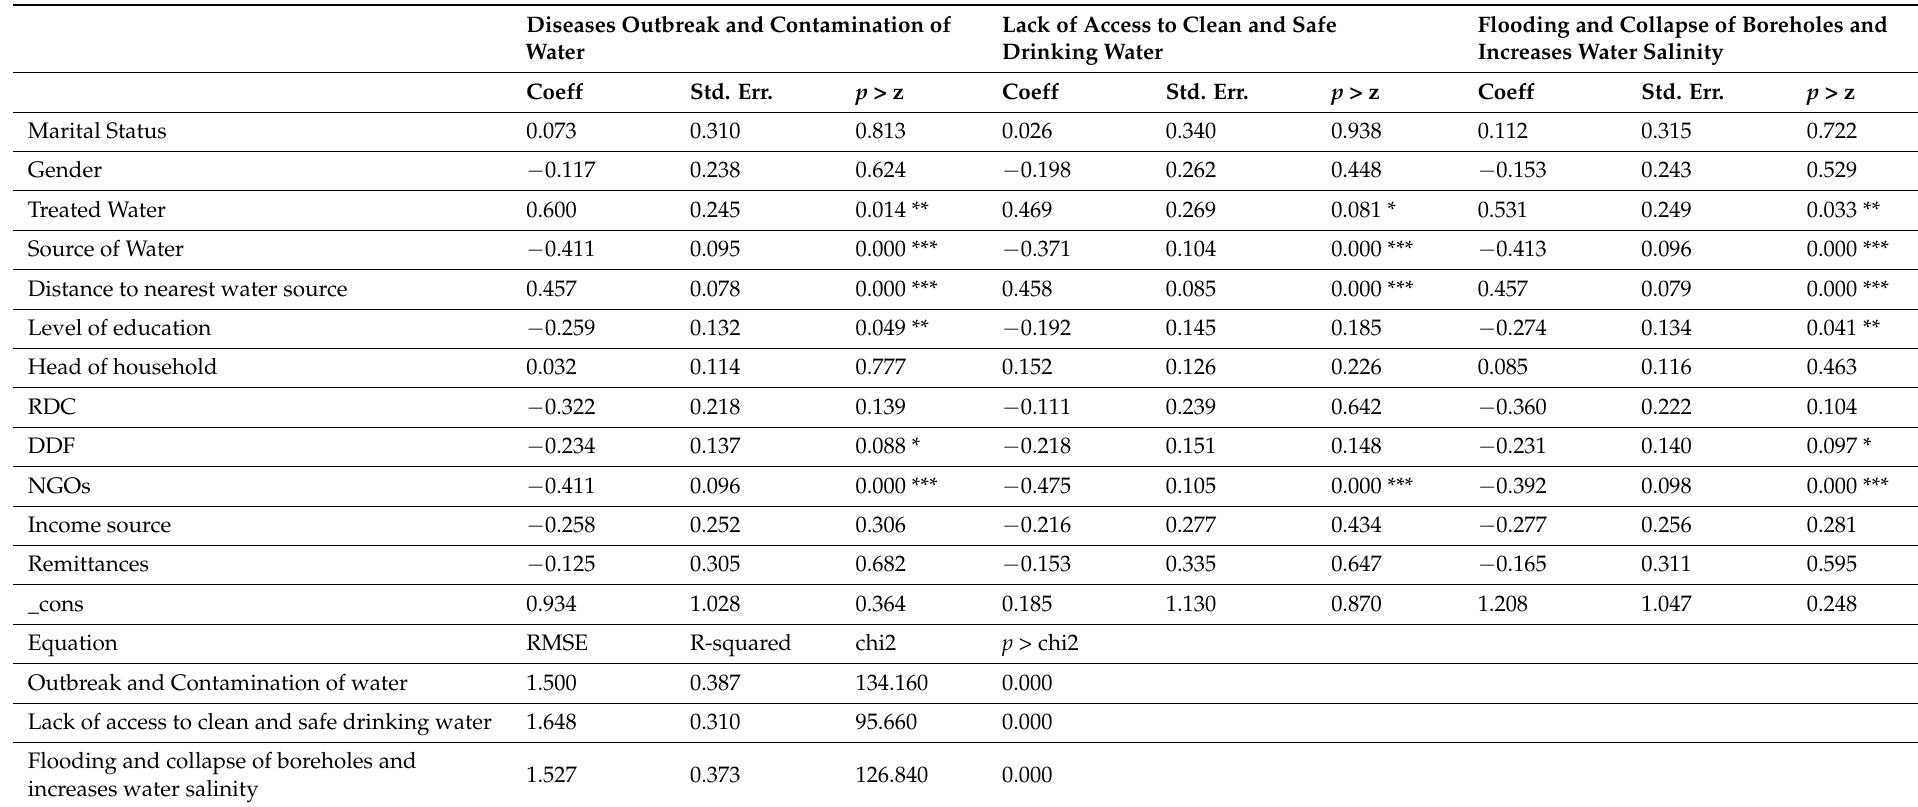
Table 3. A seemingly unrelated regression model of factors influencing the experience of flood incidences in Tsholotsho. Diseases Outbreak and Contamination of Water